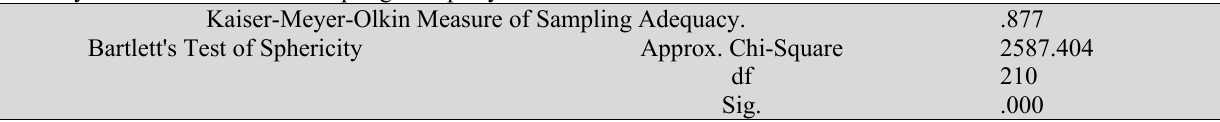
Fig. 1. Scree Plot for Factors Extraction